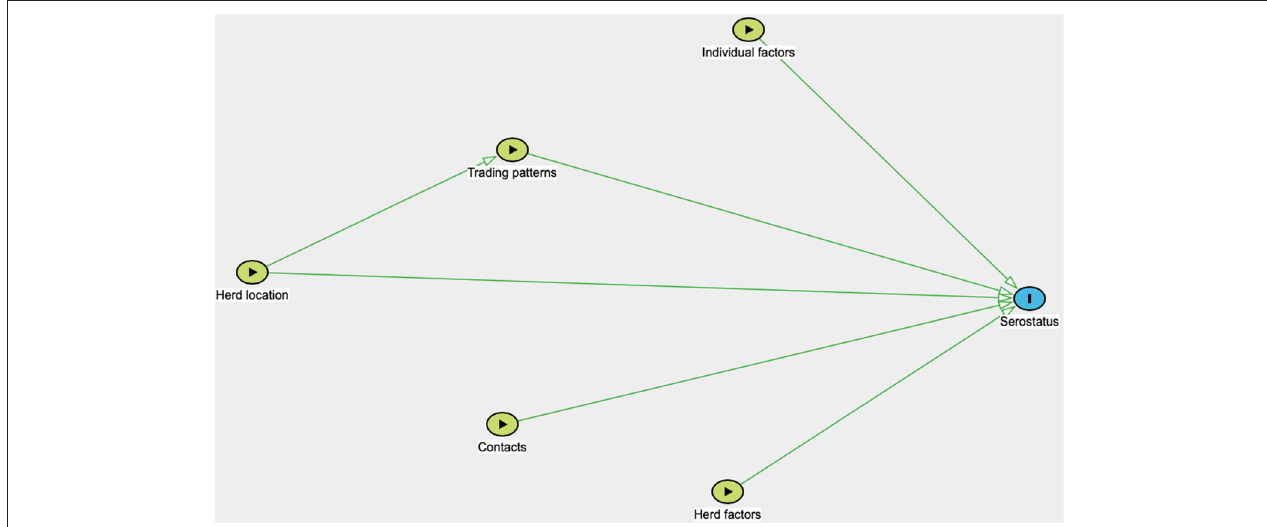
FIGURE 2 | Directed acyclic graph illustrating variables potentially associated with pathogen seroprevalence. Herd location include the village-location, district-location and country-location of the sampled herd, as well as distance to the nearest international border, town and the Tan-Zam highway. Trading patterns include introduction of new animals, selling, buying from traders or at markets, and buying from or selling to other countries. Contact includes contact with wildlife and sheep, goats and cattle from other herds. Individual factors include age, sex, and species. Herd factors include herd